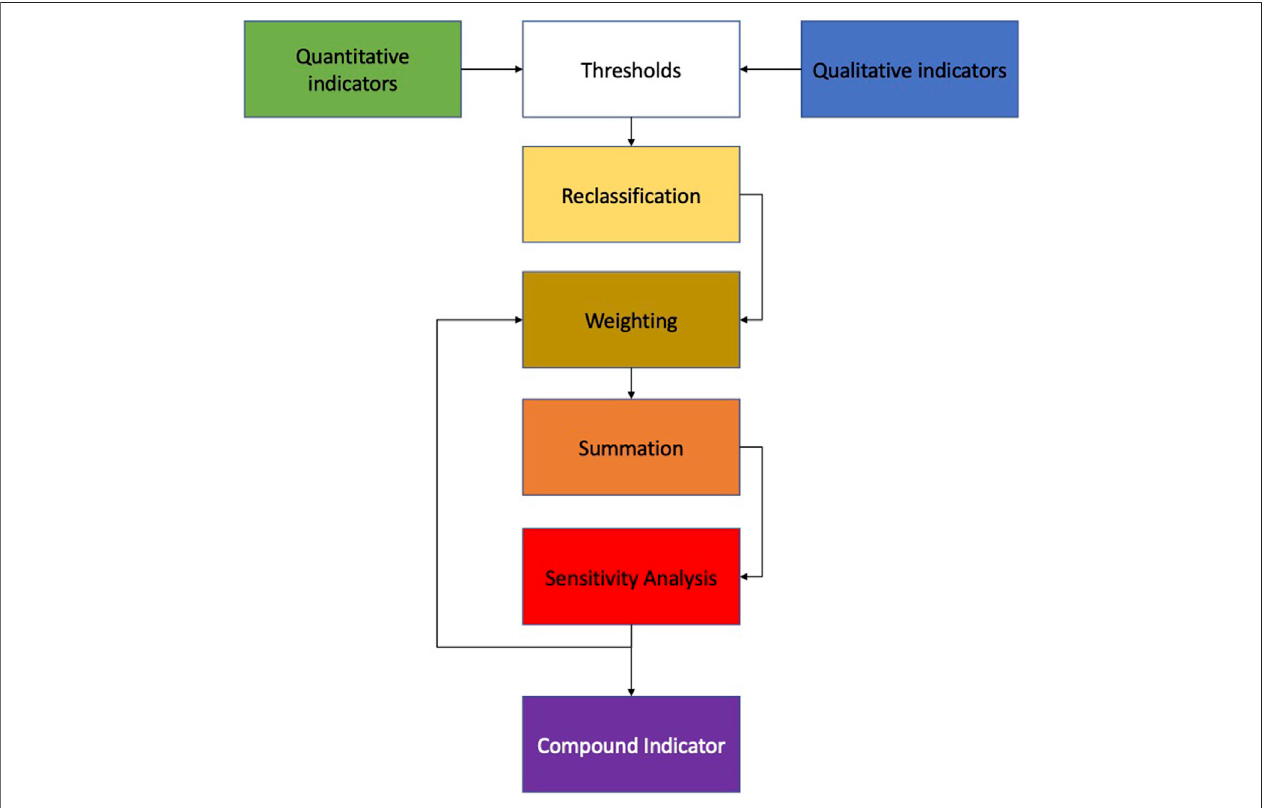
FIGURE4| Sequenceofstepsenvisagedtogenerate compound indicators forNBSperformanceagainst landslidesand erosionusing therepository ofindicators de fi ned with the ‘ rocket framework ’ .